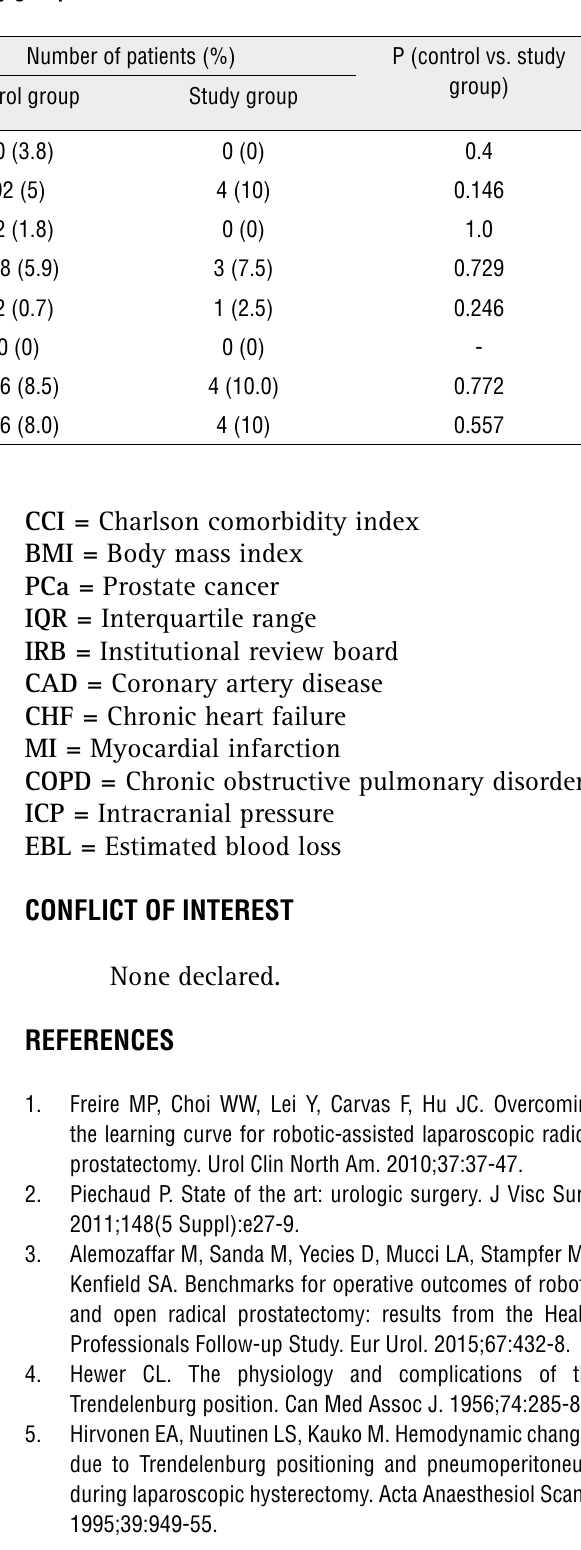
Table 4 - Clavien grading of complications in control and study groups. Clavien grading